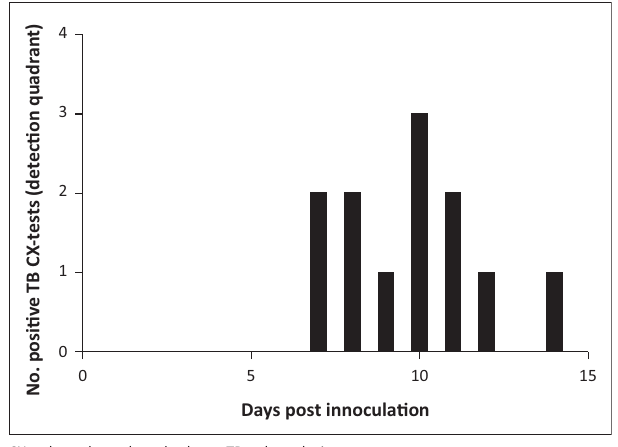
FIGURE 2: Time to positive tuberculosis CX-test.